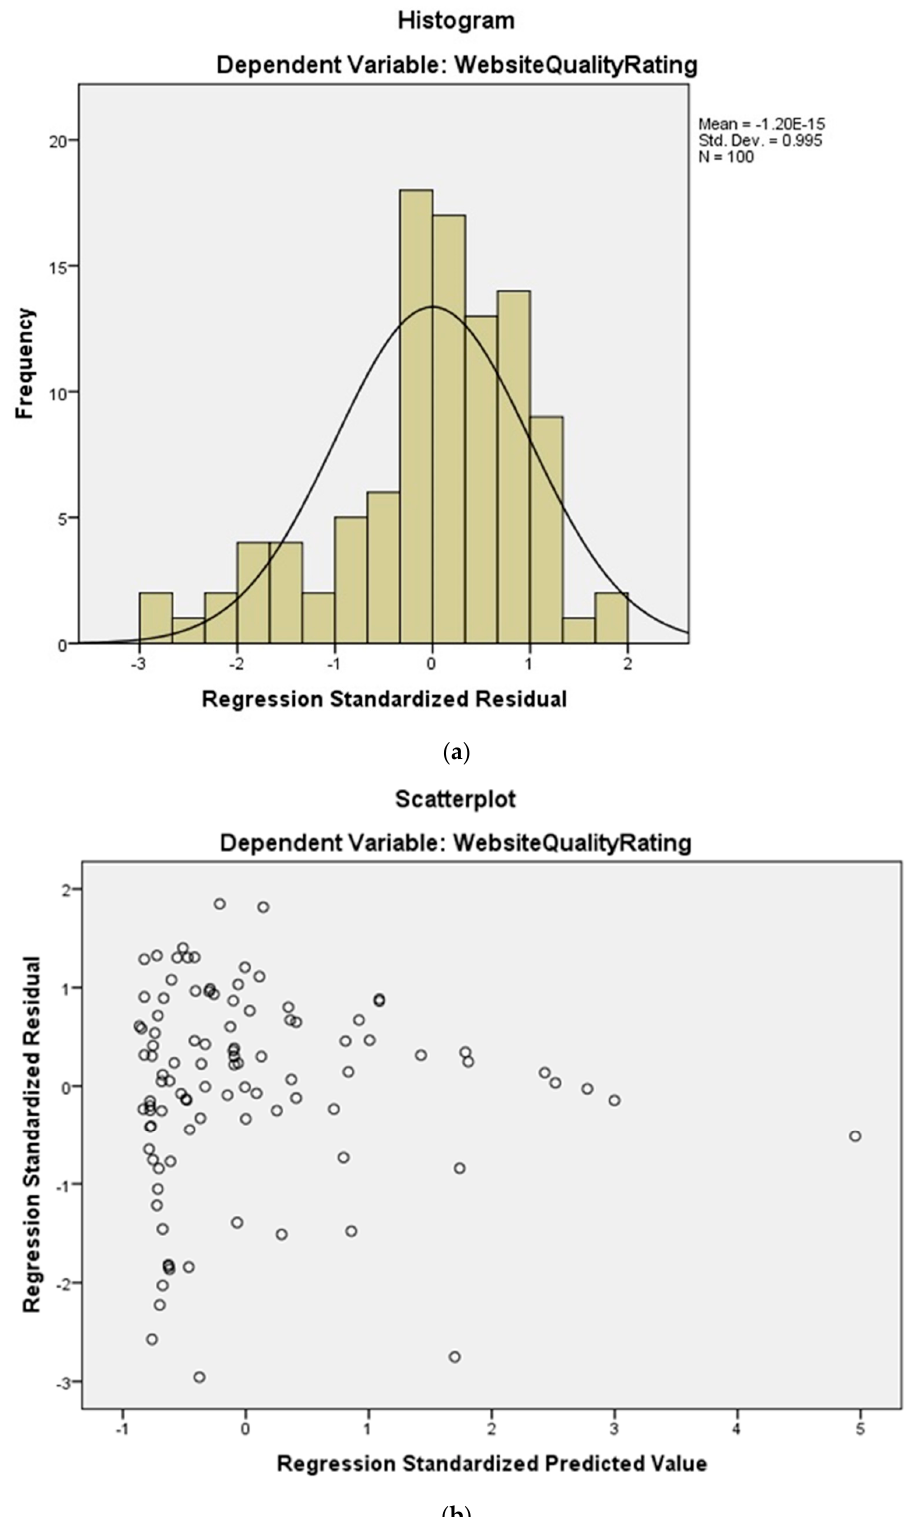
Figure 1 . ( a ) The histogram of the standardized residuals shows a normal distribution. ( b ) The scatterplot shows that there are no clear patterns except a slight “heteroscedasticity” which makes this predictive model uncertain.